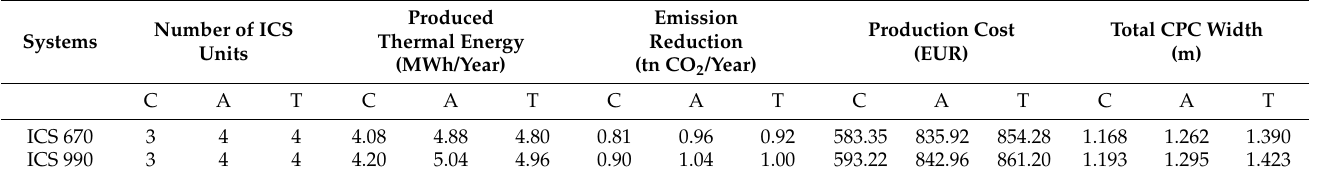
Table 3 are classified using the keywords C: Chania, A: Athens, T: Thessaloniki. In Table 4, the environmental impacts in the production and installation phase are presented. Both redesigned best cases systems behave the same for all components. Table 3. Number of ICS units produced thermal energy, greenhouse gas emissions and optimum dimensions of the reflector for the two selected, by the algorithm, best cases for three different geographic locations in Greece.